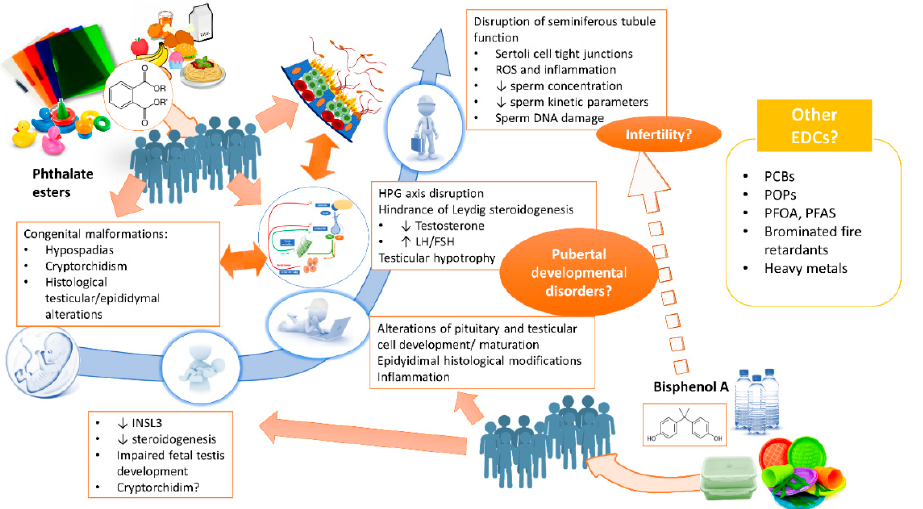
Figure 1. Effects of BPA and phthalates on the development and function of the male reproductive tract. Abbreviations: polychlorinated biphenyls (PCB), persistent organic pollutants (POP), polyfluoroalkyl acids (PFAS), perfluorooctanoic acid (PFOA).